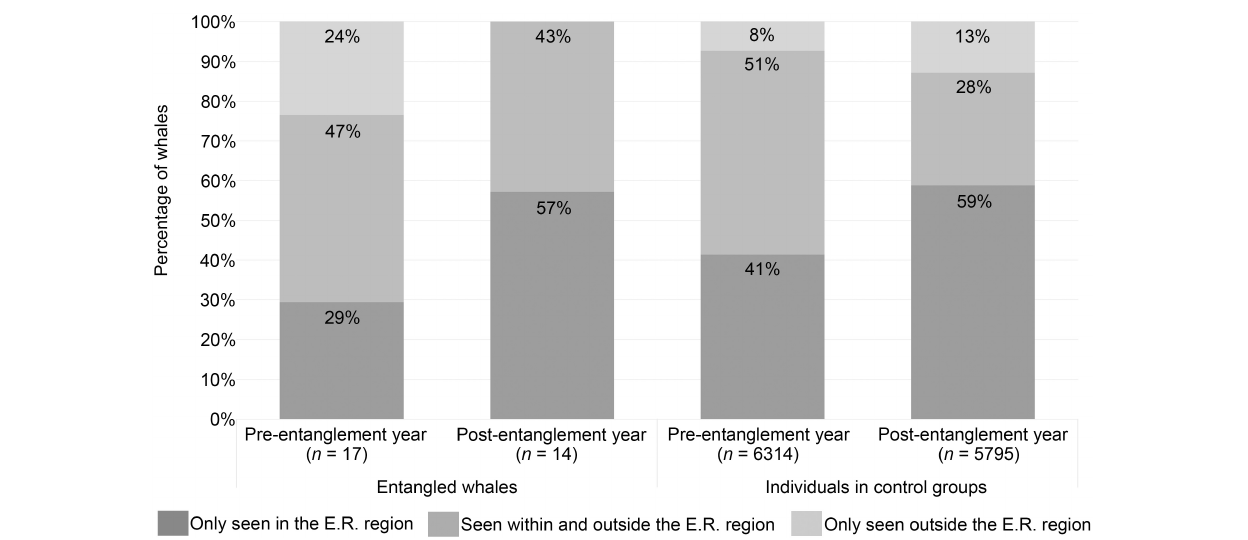
FIGURE 3 | Percentage of whales seen within and outside of the initial entanglement report region (E.R. region) pre- and post-entanglement year. All the entangled whales resighted post-entanglement were documented at least once in the same region as their initial entanglement report. Returning to the same region post-entanglement, combined with the high percentage of whales with pre-entanglement sighting history seen within the region of their entanglement, suggests that the entangled whales in this study were not “out-of-habitat” when initially reported entangled. Additionally, the percentage of entangled whales seen within, outside, or both within and outside the E.R. regions compared to the control groups did not deviate from expected values for before, during, or after the entanglement year (Fisher’s Exact test two-sided, before: p = 0.0605; during: p = 0.3526; after: p = 0.2615), suggesting that selecting individuals based on the E. R. region proved suitable control